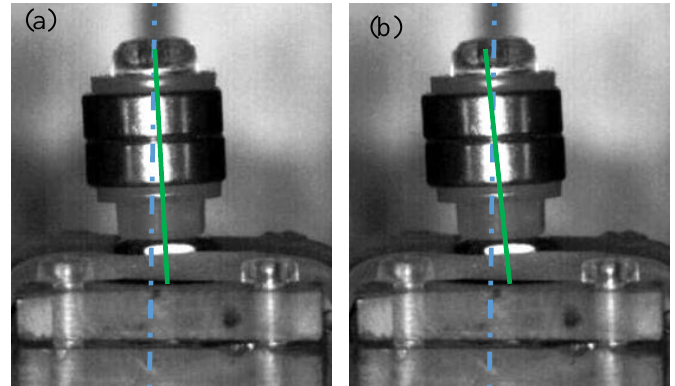
Figure 5. The captured images (front view) show the beam motion of the AC magnetic sensor under: ( a ) zero magnetic field (initial state) and ( b ) x -axis magnetic field. Note: The shooting speed and sensitivity for image capture of the high-speed camera is 500 fps and ISO-1600, respectively. Additionally, for videos, please see the Supplementary Materials for a clearer motion of the sensor under an in-plane magnetic field.